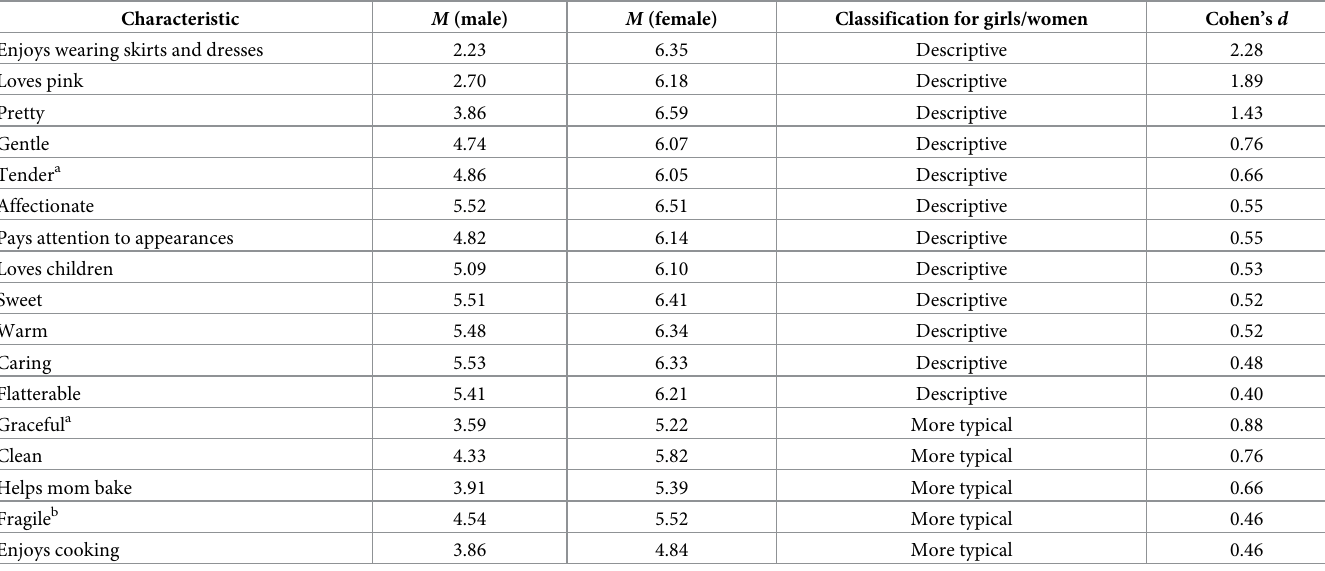
Table 4. Characteristics rated as consistently more typical for girls/women than boys/men across the lifespan. Characteristic M